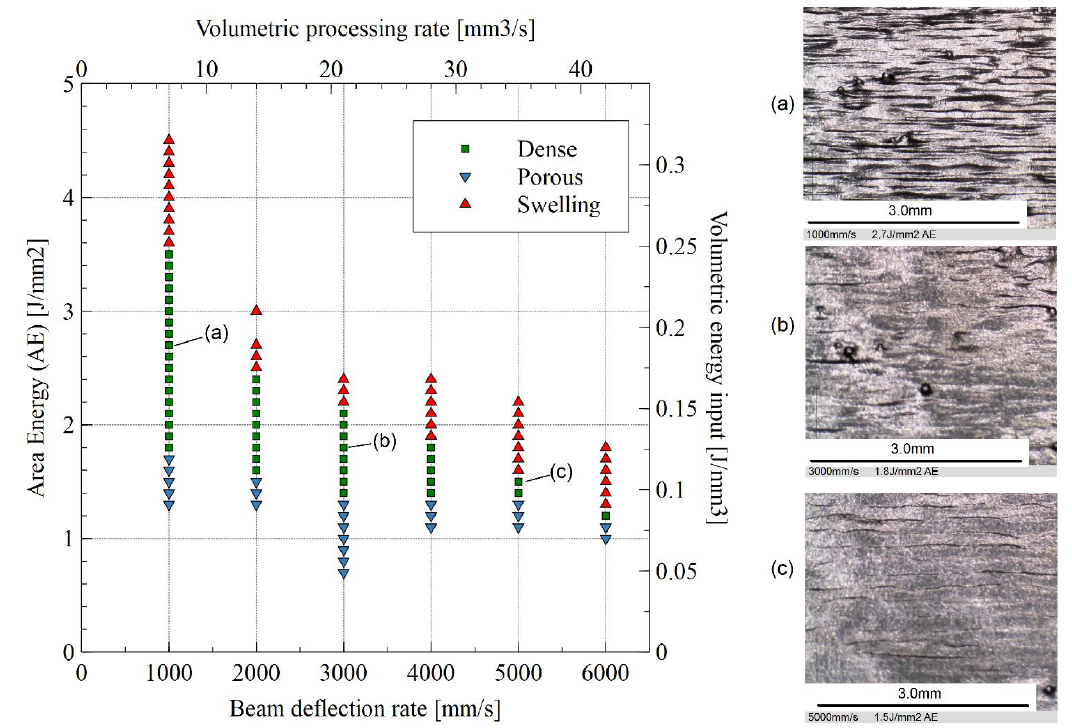
Figure 3. Process window for electron beam melting (EBM)-processed 316LN stainless steel at 70 um layer thickness and 0.1 mm line spacing; ( a – c ) the top surfaces of the specimens and their respective positions in the process window. For ease of comparison to other process development studies, volumetric energy (accounting for layer thickness), and volumetric processing rate have been added as secondary axes. Density measurements showed a well-defined point of AE below which the samples had decreasing density (Figure 4). In addition, the density of the samples increased as the AE increased, even when entering the swelling region of the process window.